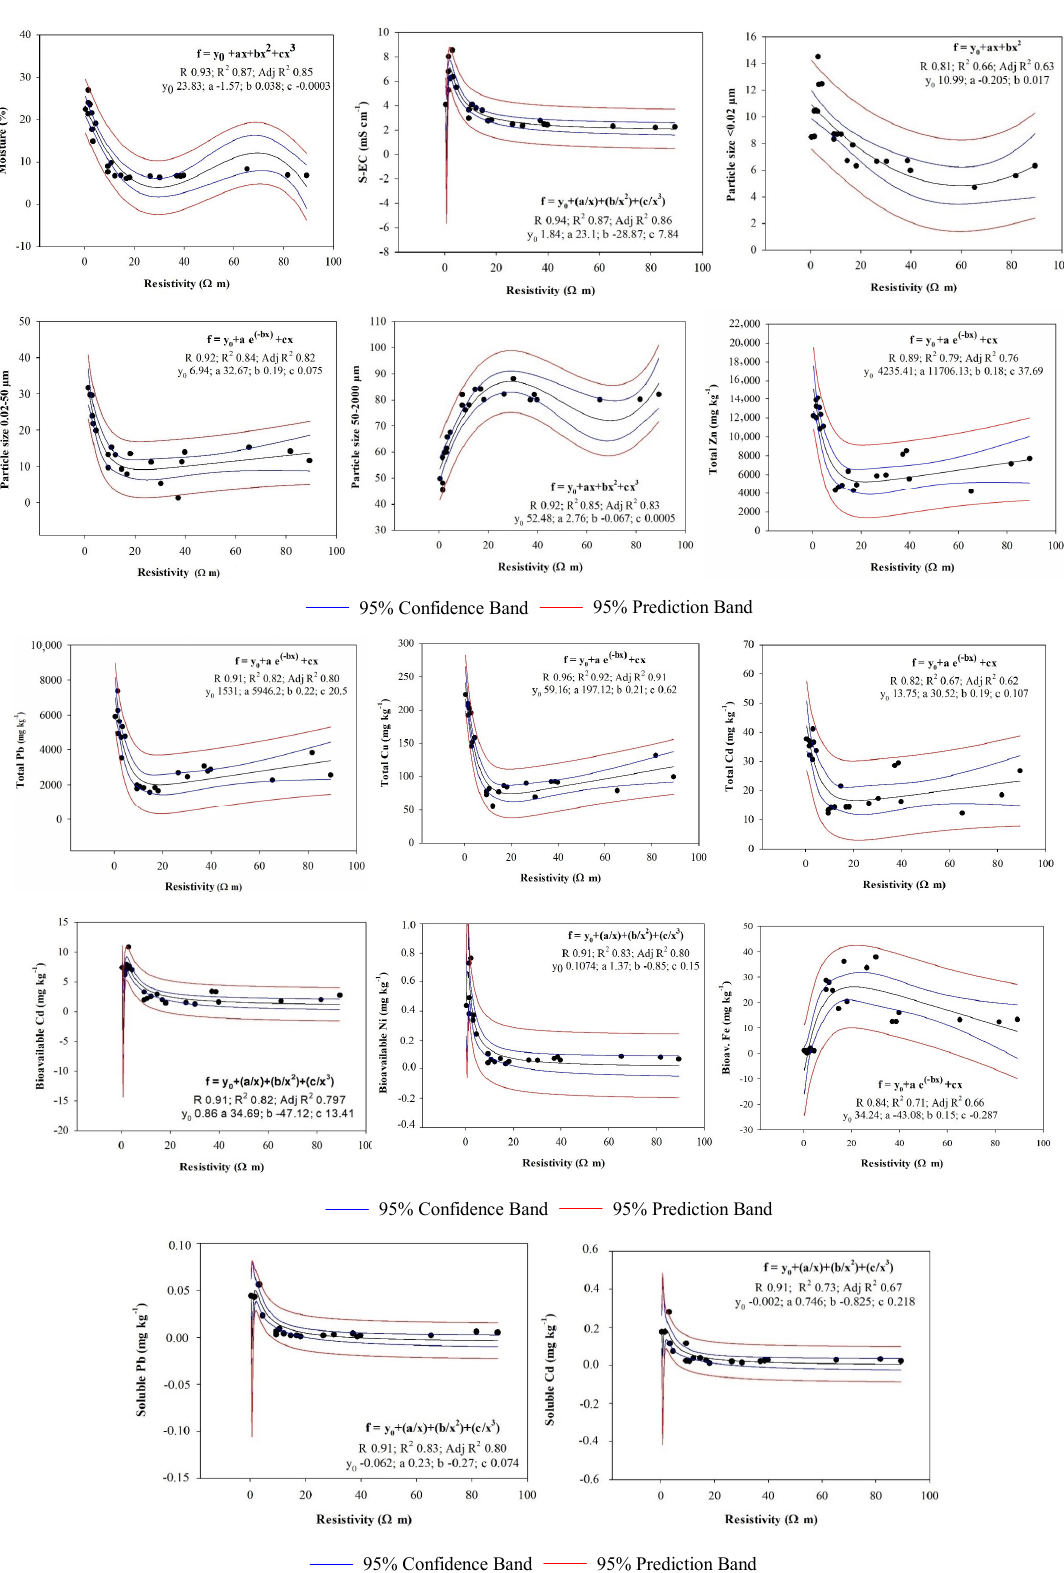
Figure 6. Calibrated model for soil properties and metal concentration estimation using resistivity as an explanatory variable (n = 24).